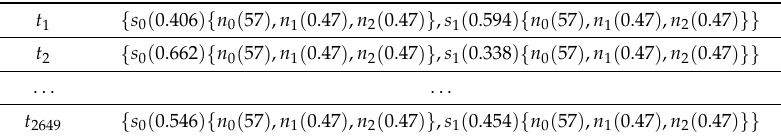
Table 8. Part of the collective overall evaluation vectors.